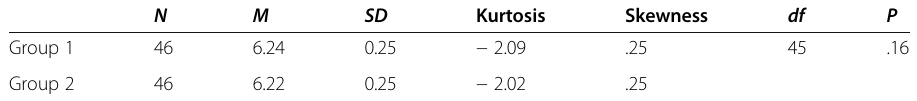
Table 2 IELTS scores of group 1 and group 2 (distribution and Mann-Whitney